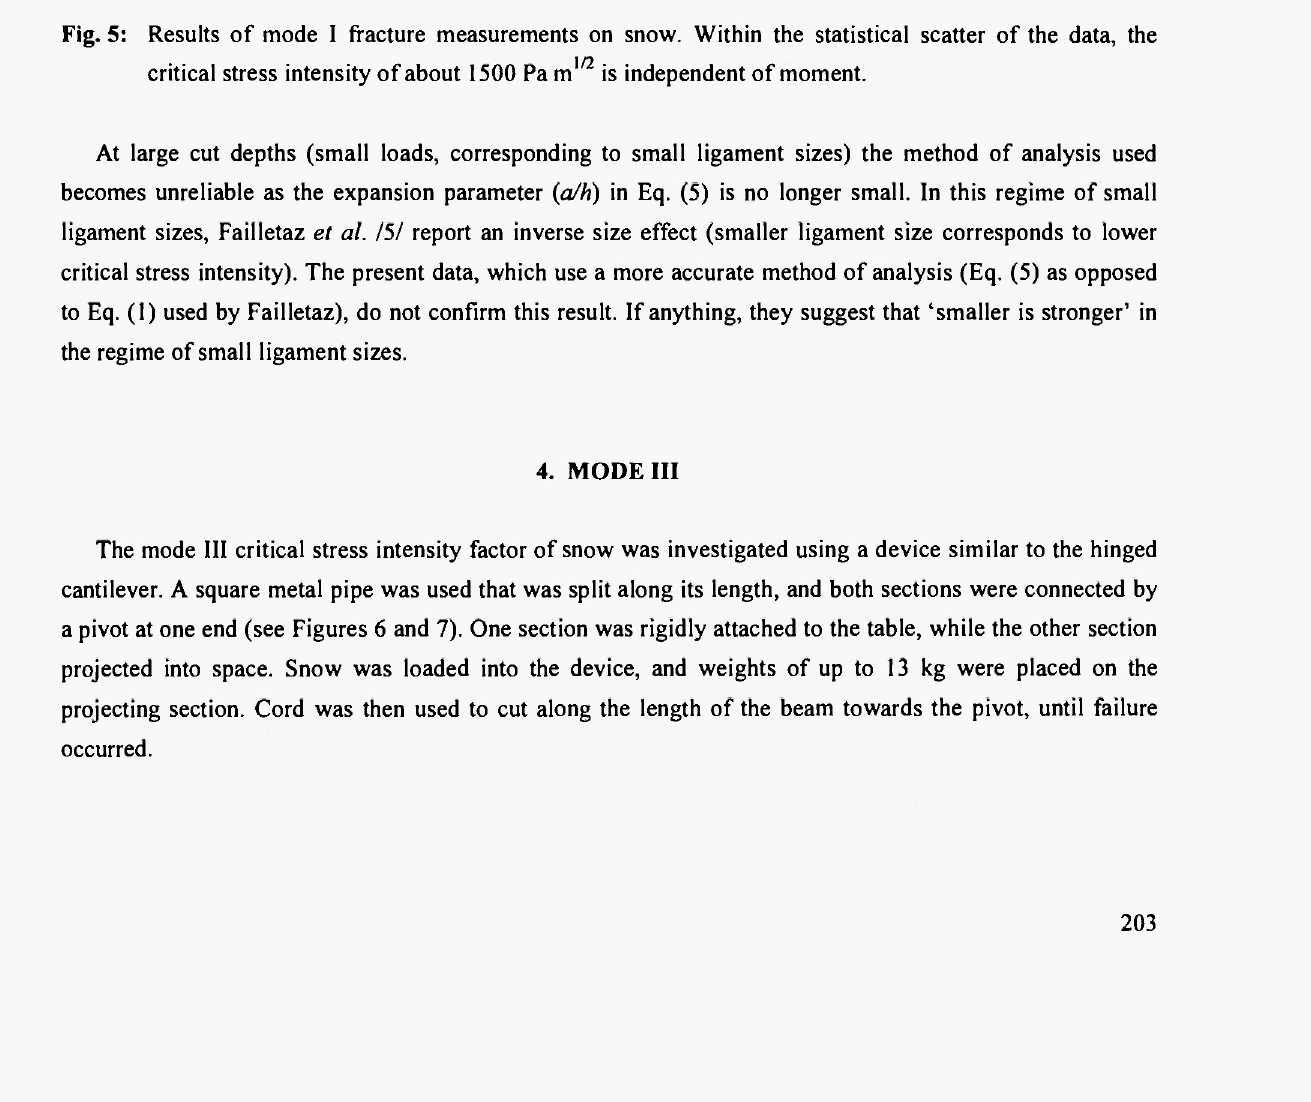
Fig. 5: Results of mode I fracture measurements on snow. Within the statistical scatter of the data, the critical stress intensity of about 1500 Pa m l/2 is independent of